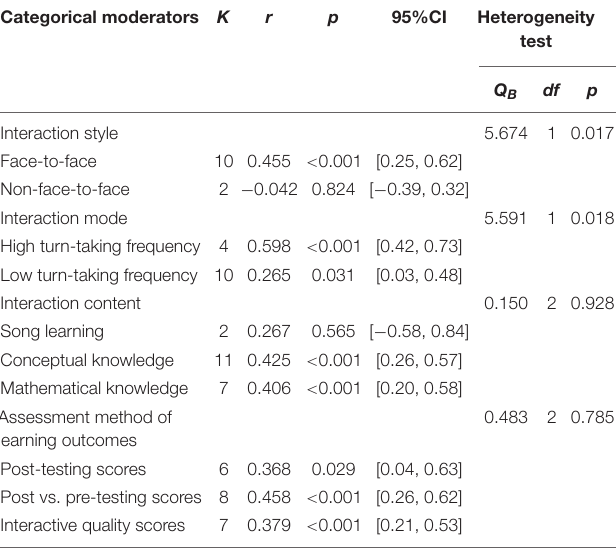
TABLE 3 | Moderation results of the categorical moderators (Random effects